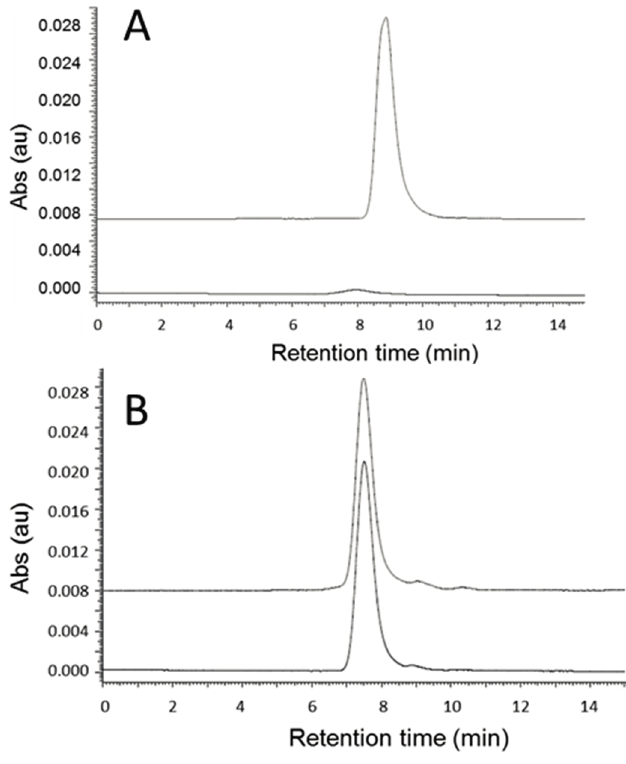
Figure 1. Cleavage of PMLA ( A ) and multifunctional nanoconjugate ( B ) by mild ammonolysis in aqueous